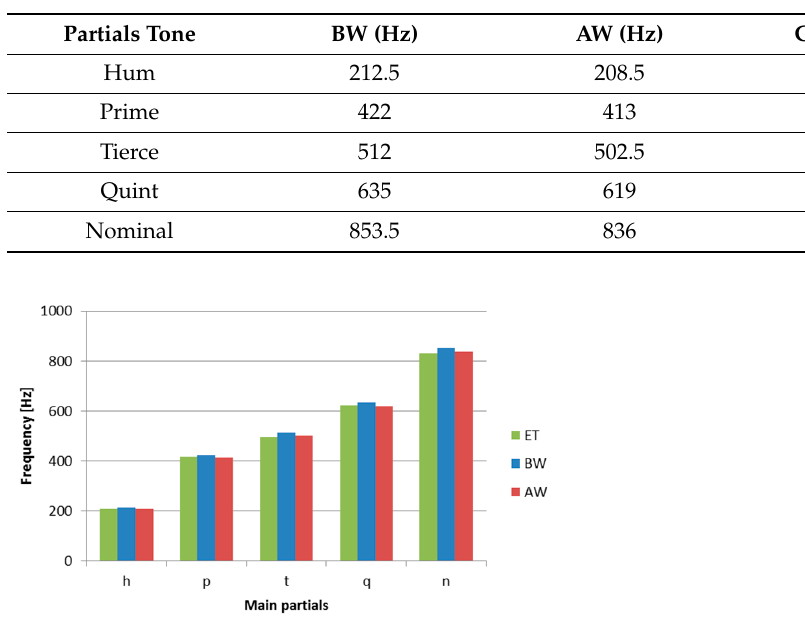
Figure 10. The analysis of sound wave emitted by bell C3 in program Wavanal; ( a ) the shape of recorded wave, ( b ) its spectrum. Table 3. Main partials of the St. Maryan bell’s sound frequencies before and after welding in comparison to harmonic tones for the musical note G#4.